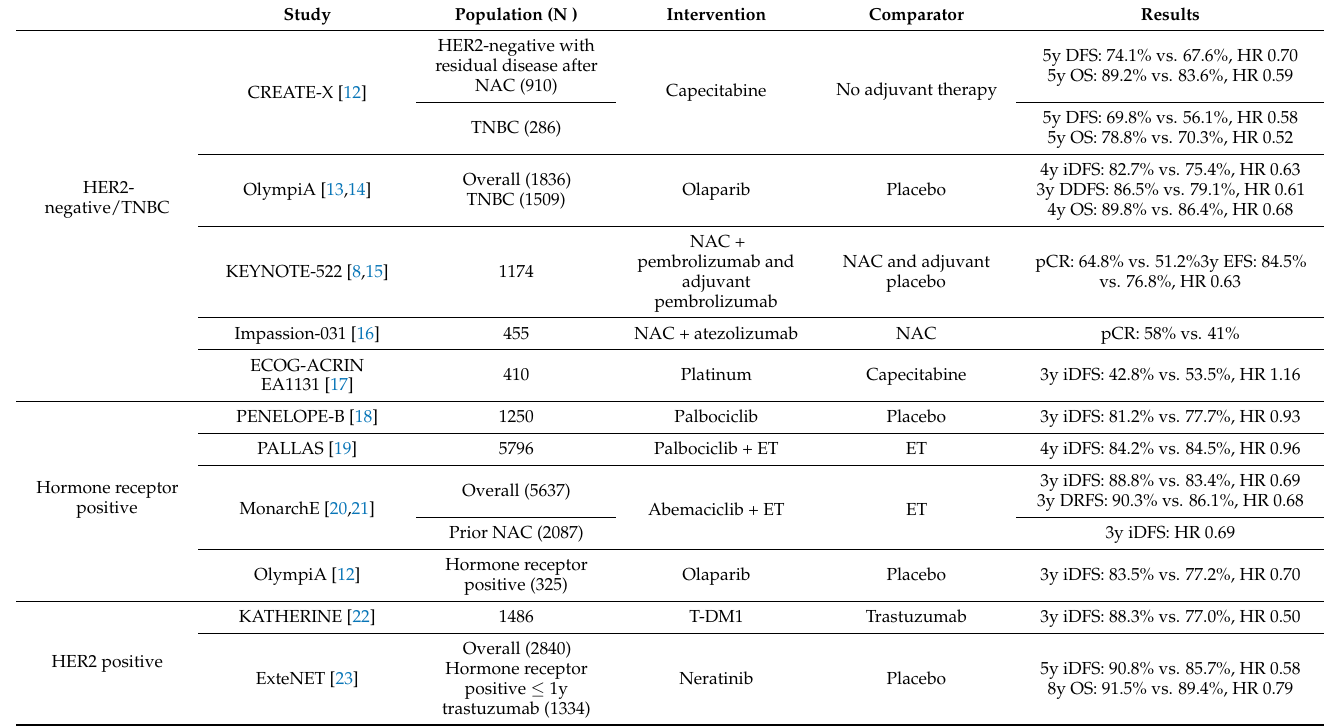
Abbreviations: DDFS: distant disease-free survival; DRFS: distant relapse-free survival; EFS: event-free survival; ET: endocrine therapy; HR: hazard ratio; HER2: human epidermal growth factor receptor 2; iDFS: invasive